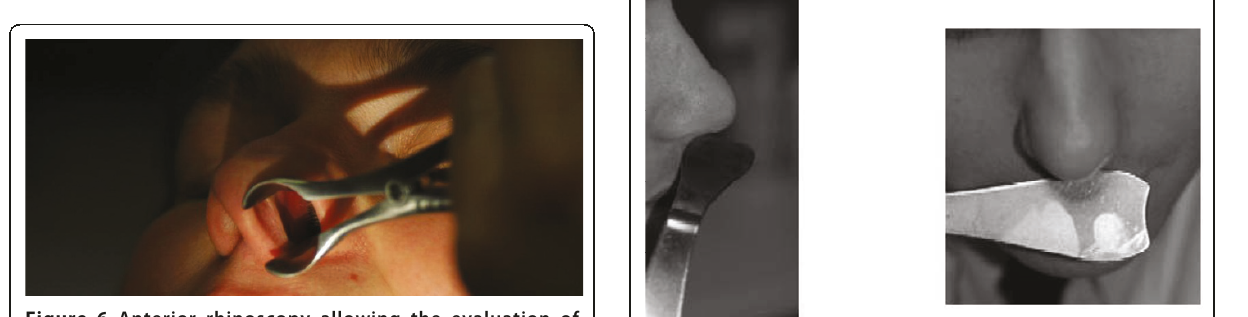
Figure 7 Mirror test for evaluation of the condensate of expired air on a cold metal instrument or mirror